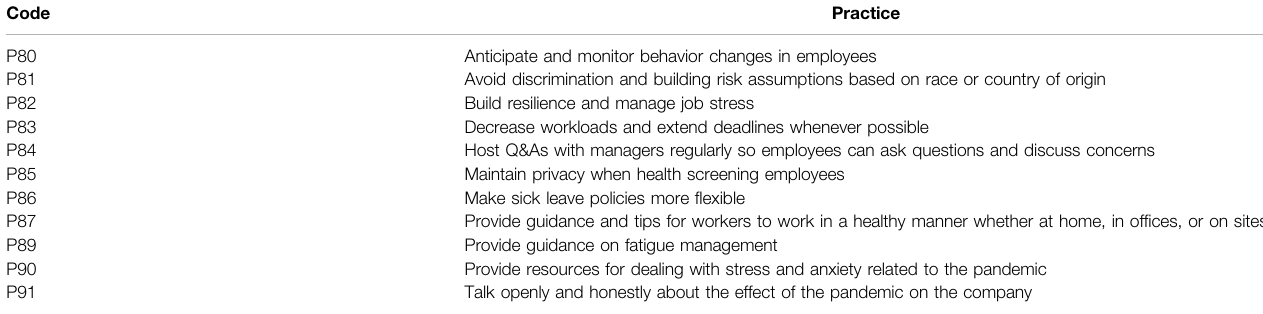
TABLE 12 | Recommended practices to ensure physical and mental health.